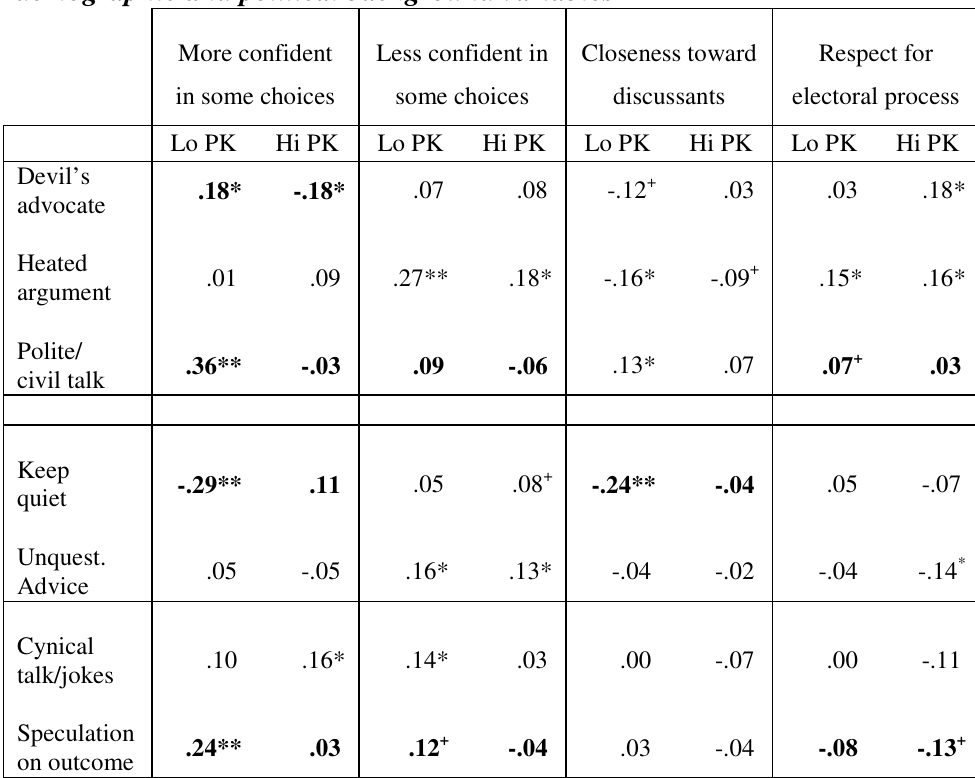
Comparison of partial correlations between discussion elements and outcomes for low- and high-political knowledge (PK) discussants, controlling for demographic and political background